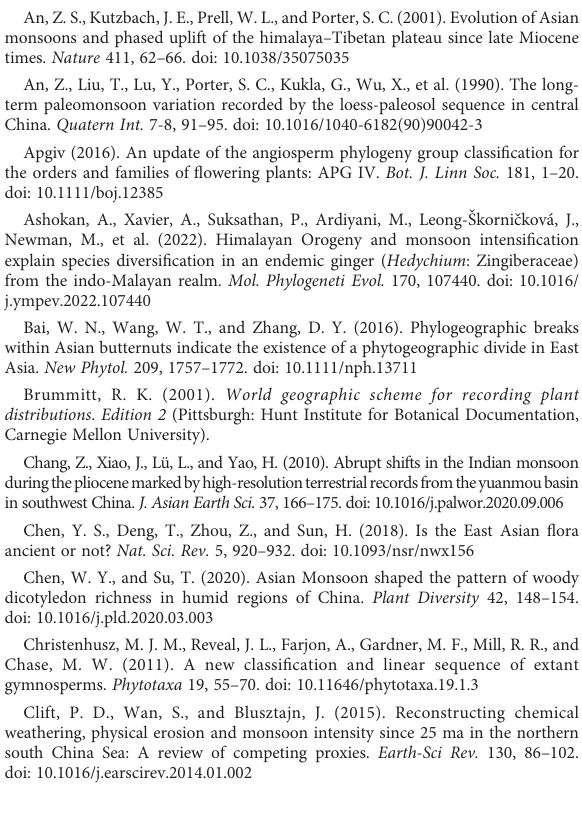
SUPPLEMENTARY FIGURE 1 Comparison of diversi fi cation dates between monotypic and polytypic endemic seed plant taxa of East Asia. SUPPLEMENTARY FIGURE 2 Number and accumulated ratio (red line) of diversi fi cation dates of 76 polytypic endemic seed taxa of East Asia in one-million-year